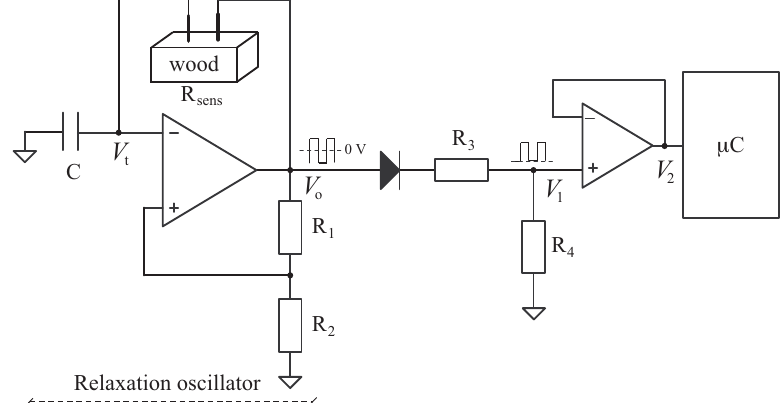
Figure 1. Supporting electronic circuit for the proposed Alternating Current (AC) measurement method. The relaxation oscillator tunes frequency depending on wood properties, mainly, Moisture Content (MC) and